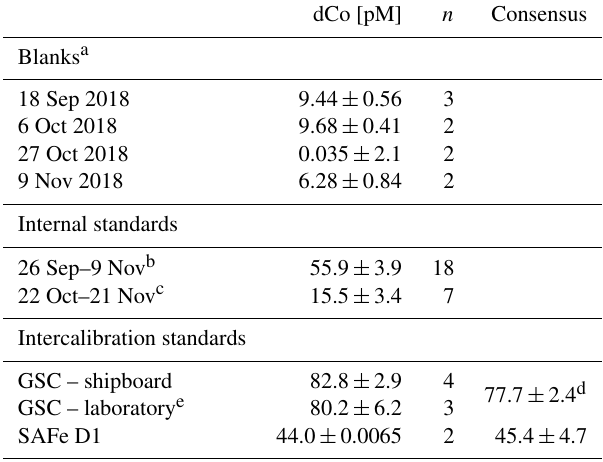
Table 1. Blanks, internal standard and GEOTRACES community intercalibration standards measured at sea during Co